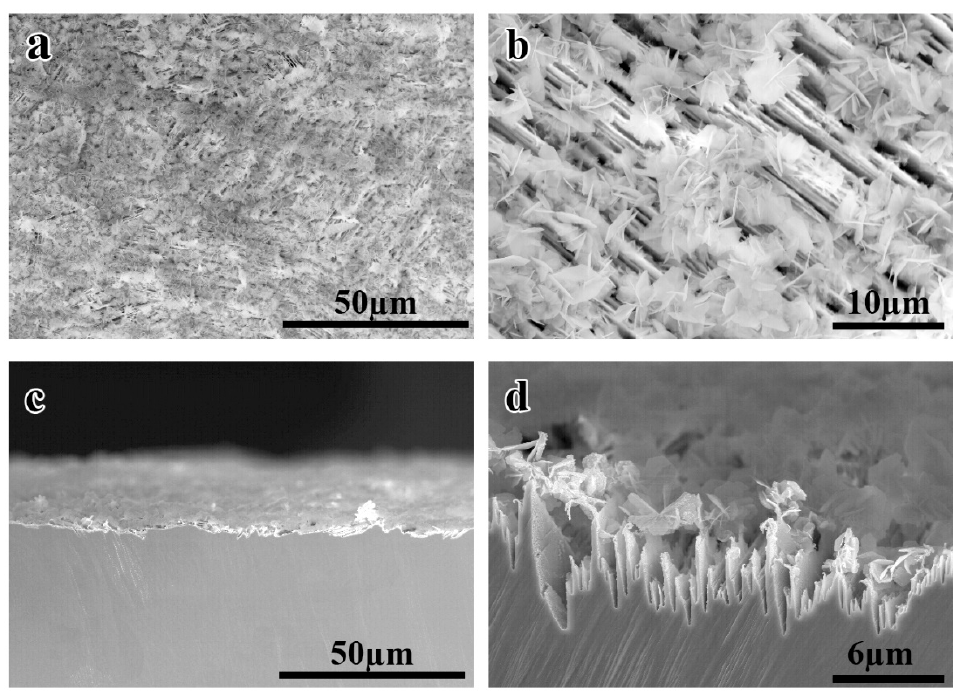
Figure 1. SEM micrographs of samples after anodization at 10 V for 15 min: ( a , b ) top-view with different magnifications. ( c , d ) cross-section with different magnifications.